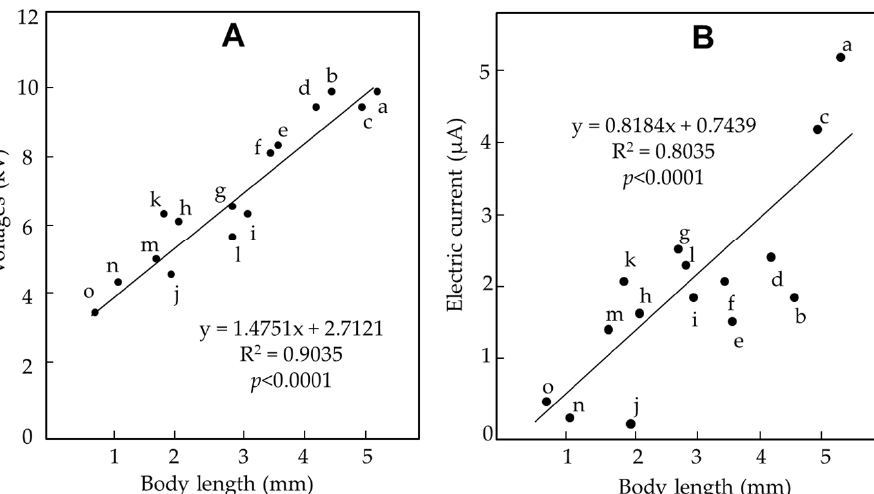
Figure 3. Relationships between insect body size and minimum voltage for 100% insect capture ( A ) and insect body size and the magnitude of the insect electric current at − 13.1 kV ( B ). a, German cockroach; b, rice weevil; c, green rice leaf hopper; d, greenhouse shore fly; e, adzuki bean weevil; f, red flour beetle; g, Asian tiger mosquito; h, green peach aphid; i, common clothes moth; j, bathroom fly; k, western flower thrip; l, oriental termite; m, tomato leaf miner fly; n, book louse; o, whitefly [22].